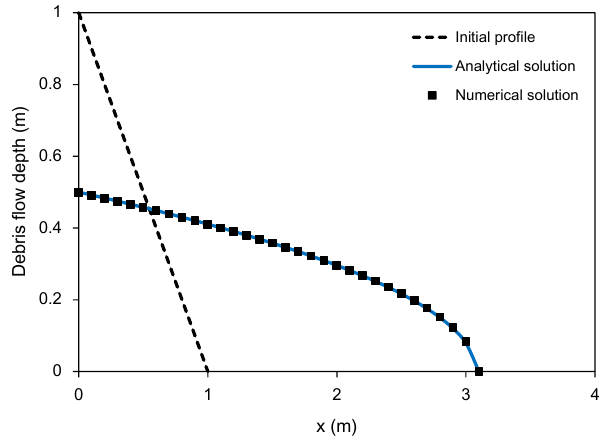
Figure 7. Comparison of the final debris flow depth profiles from the analytical solution and the numerical solution in Test 1.